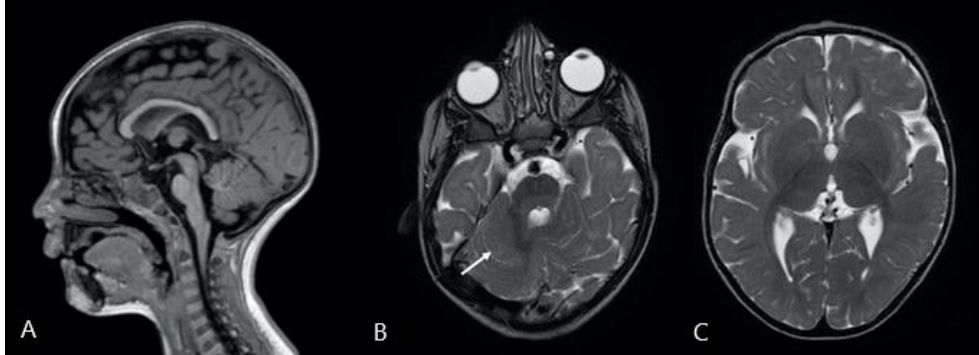
Figure 2. Description: ( A ): 3D-T1-weighted midline sagittal image shows a reduced thickness of the corpus callosum; the pons appears to be small and short compared to the length of the midbrain and medulla oblongata. The vermis is slightly hypoplastic with a prevalent reduction in height. ( B , C ): Turbo Spin Echo T2-weighted axial images showing ( B ) dysplastic cerebellum with abnormal foliation (white arrow), and ( C ) dysmorphic lateral ventricles, especially the frontal and occipital horns.